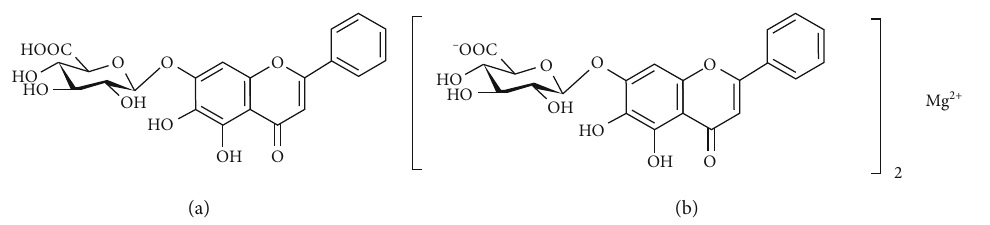
Figure 1: Chemical structures of baicalin (a) and baicalin-Mg